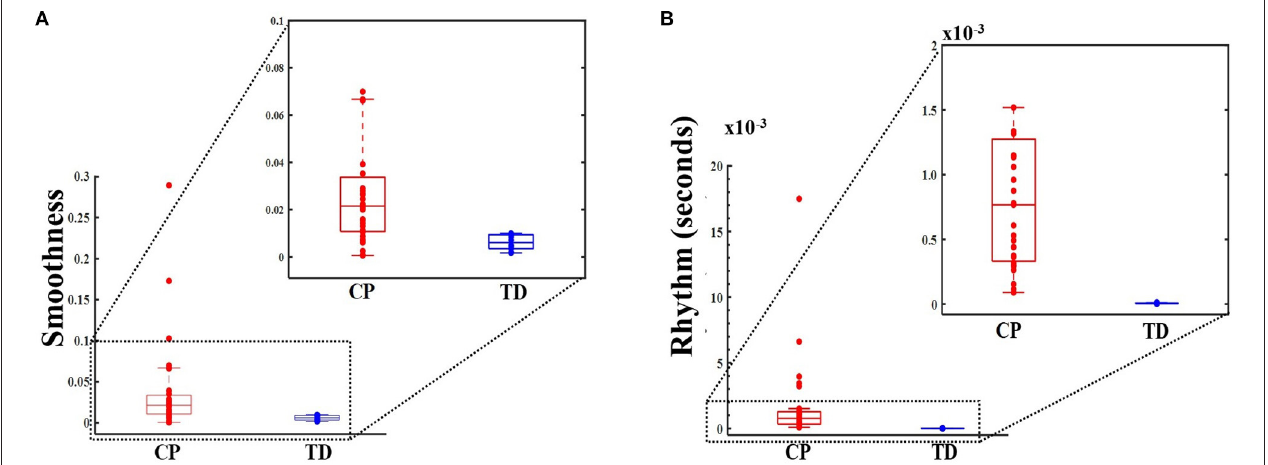
FIGURE 2 | Box and whisker plots, with scattered values (dots) indicating each data point, show increased values, i.e., less smoothness (dimensionless metric) in panel (A) (top panel) and for rhythm (in seconds) in panel (B) (bottom panel) for CP group (on the left, in red) compared to typically developing (TD) group (on the right, in blue). Higher smoothness values imply a less smooth cycling pattern. Higher rhythm values imply increased variance, and hence, poorer rhythm. The boxes depict the 25th − 75th quartile and the horizontal line depicts the median. Inset: Smoothness and rhythm values for majority of the data (excluding the extreme